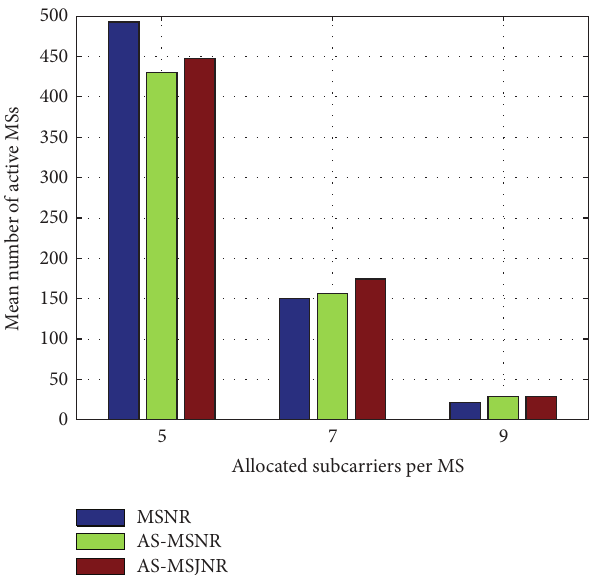
Figure 7: Mean number of active MSs for 16-QAM modulation and two tiers of cells around the central cell.